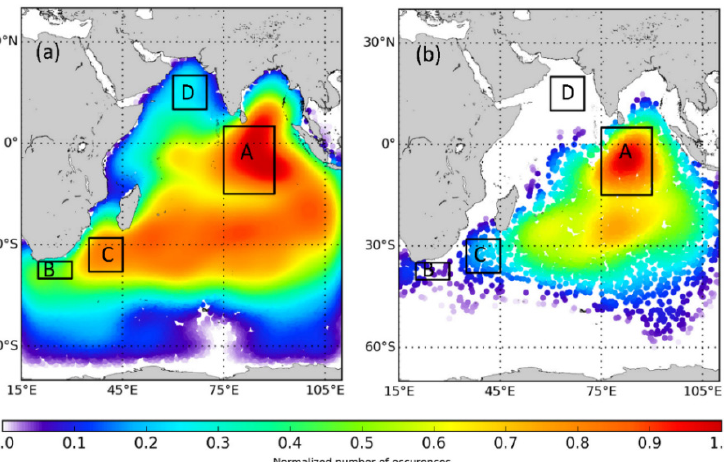
Figure 1. Distribution of Indian Ocean crossing swells from ( a ) all Level-2 swell observations and ( b ) only refocused in Level-3 “fireworks”, respectively, for 10-years Envisat wave mode Advanced Synthetic Aperture Radar (ASAR).